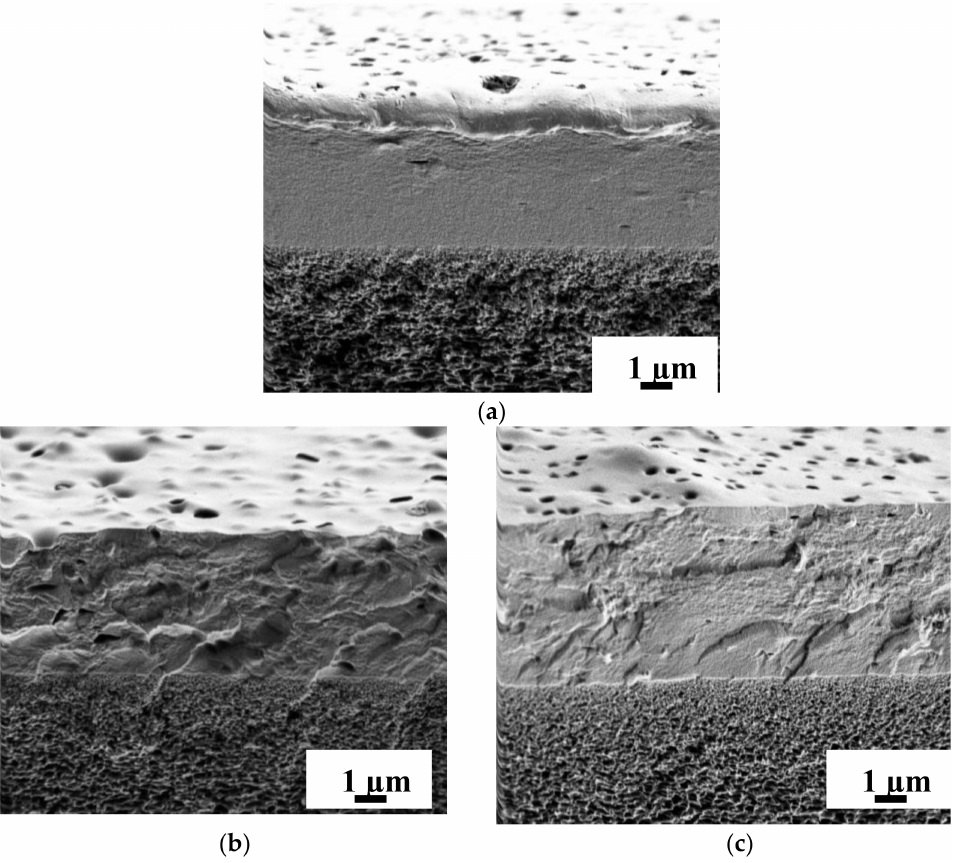
Figure 14. SEM micrographs of a cross-section of nanofiltration-supported ( a ) PIM-1, ( b ) PIM-1/MIL- 125, and ( c ) PIM-1/MIL-140A